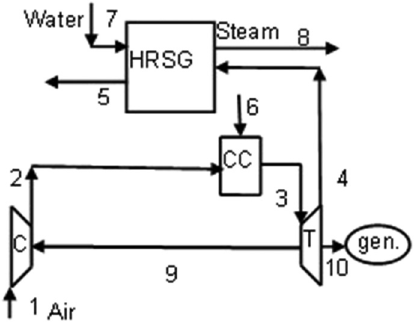
Figure 1: Schema of a basic ( bsc ) cogeneration plant.